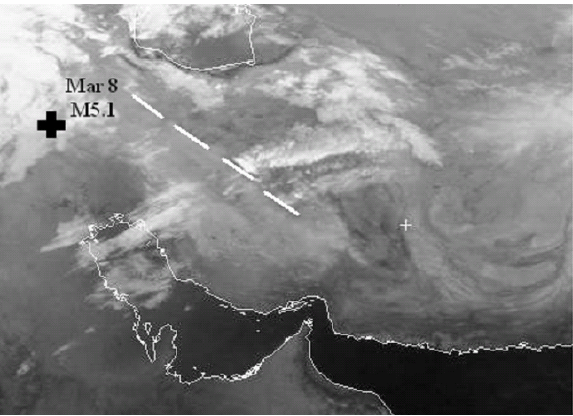
Figure 3. Cloud image at 00:00 UTC on Mar 1, 2012 Fig. 3. Cloud image at 00:00 UTC on 1 March 2012.